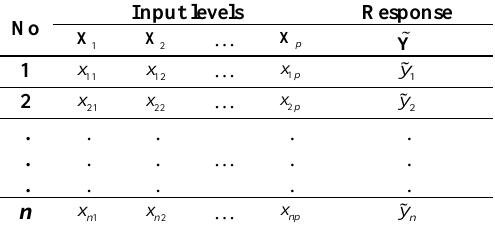
Table 2. Experimental design with fuzzy